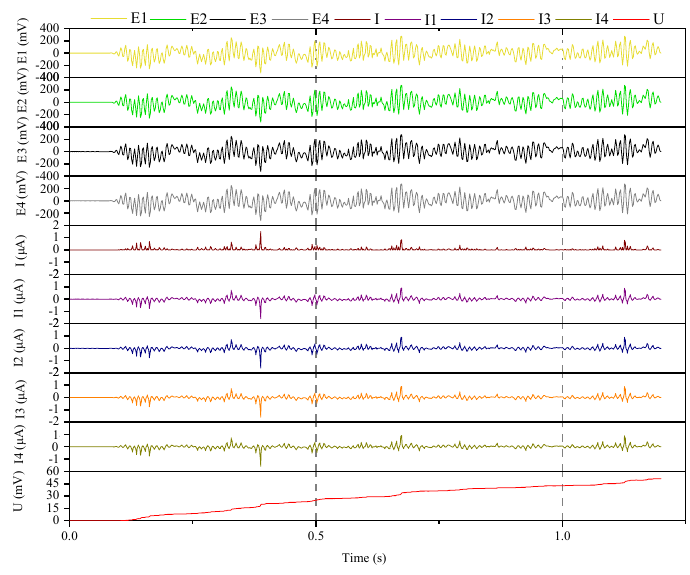
Figure 15. Array energy harvesting circuit simulation.